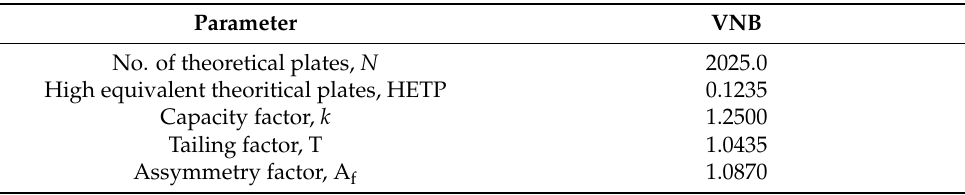
Table 2. System suitability test parameters of the established HPLC methodology for the VNB